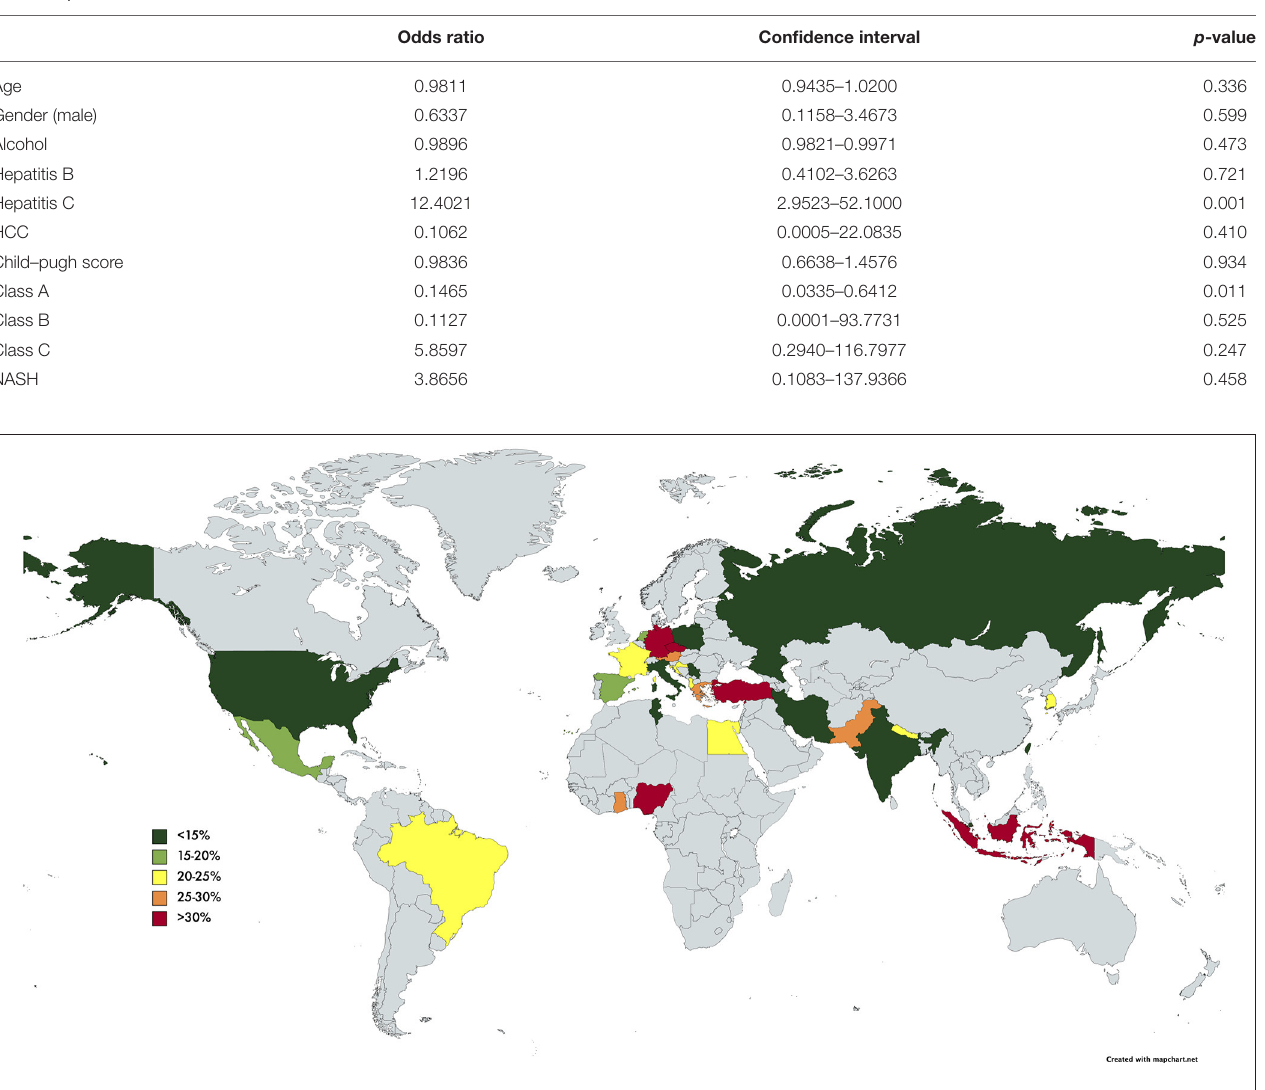
FIGURE 3 | World map of prevalence of SBP in